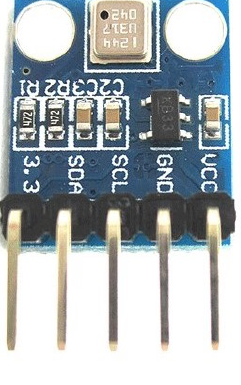
Figure 9. BMP180.